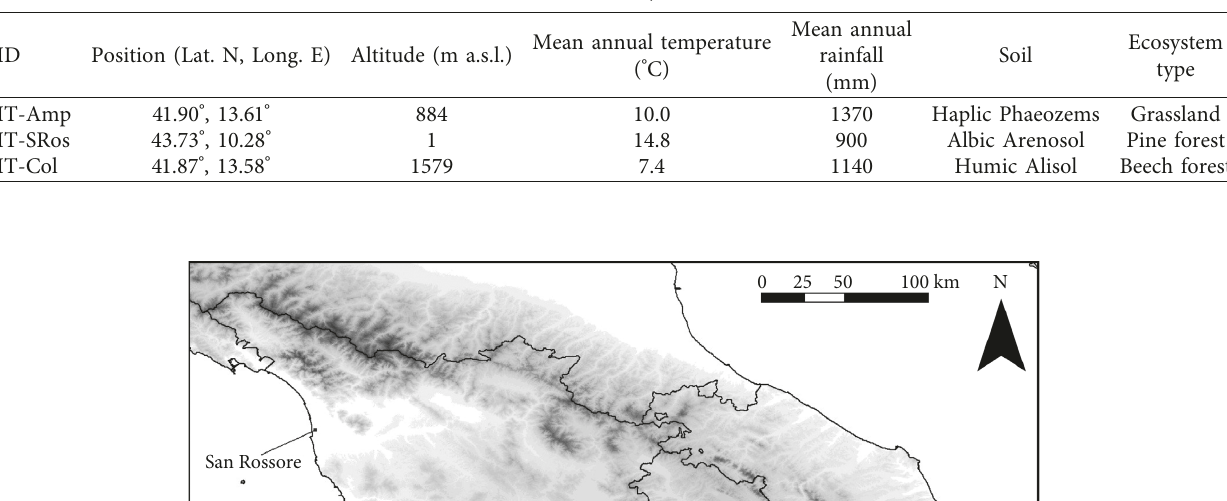
Table 1: Main ecoclimatic characteristics of the selected study sites (see the FLUXNET website for further details).